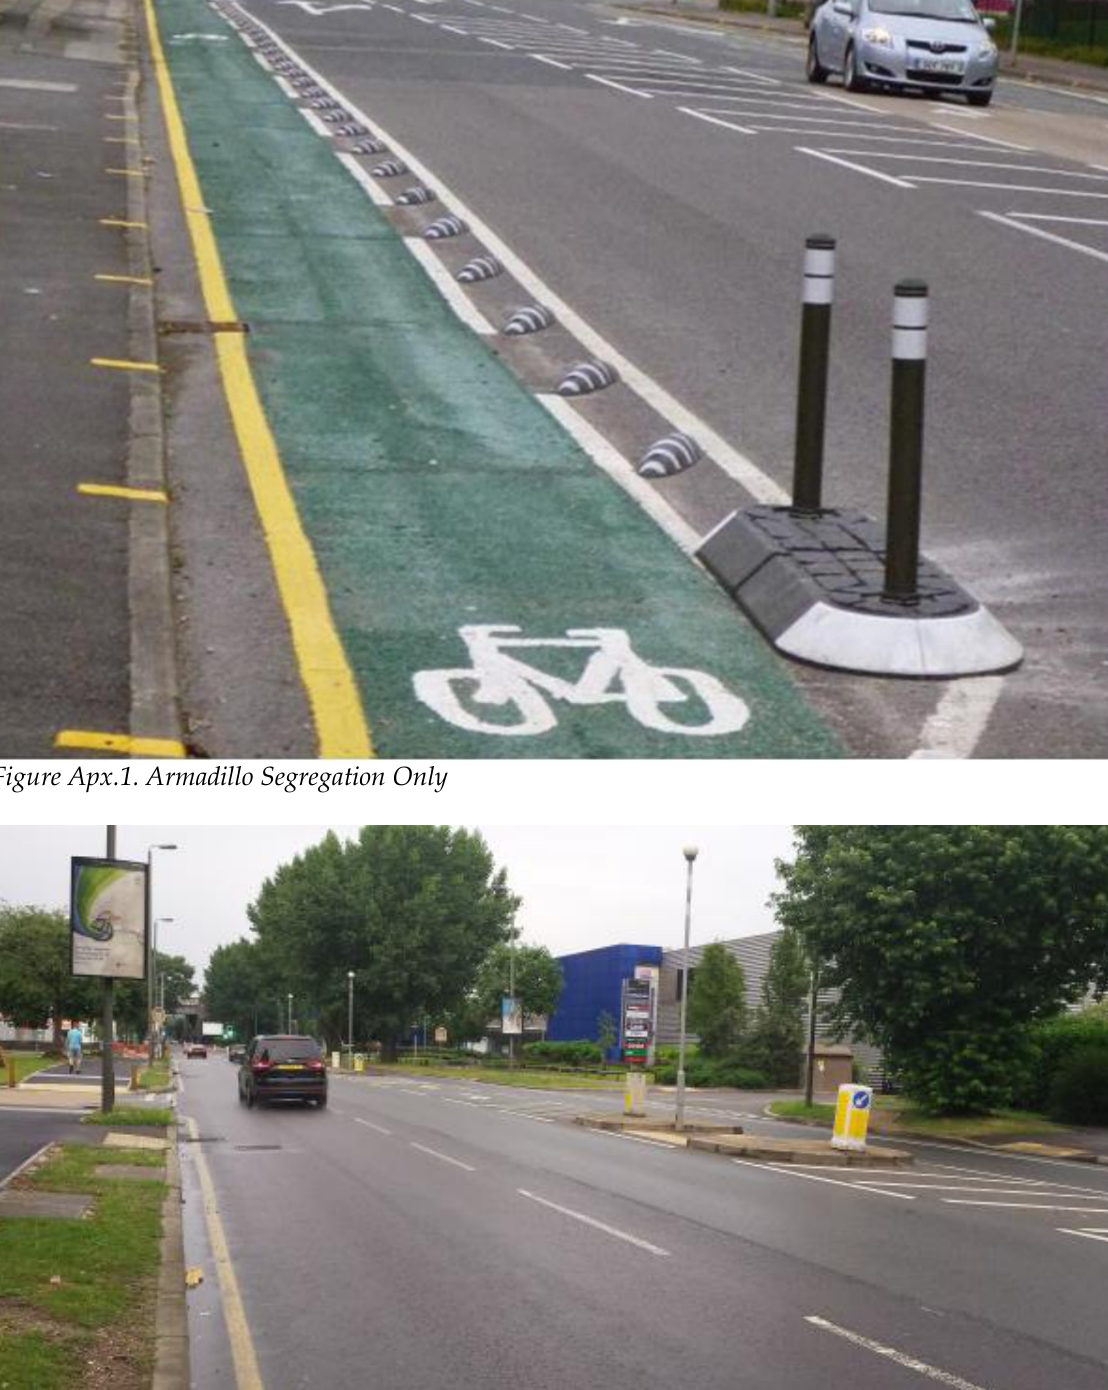
Figure Apx.2. Busy